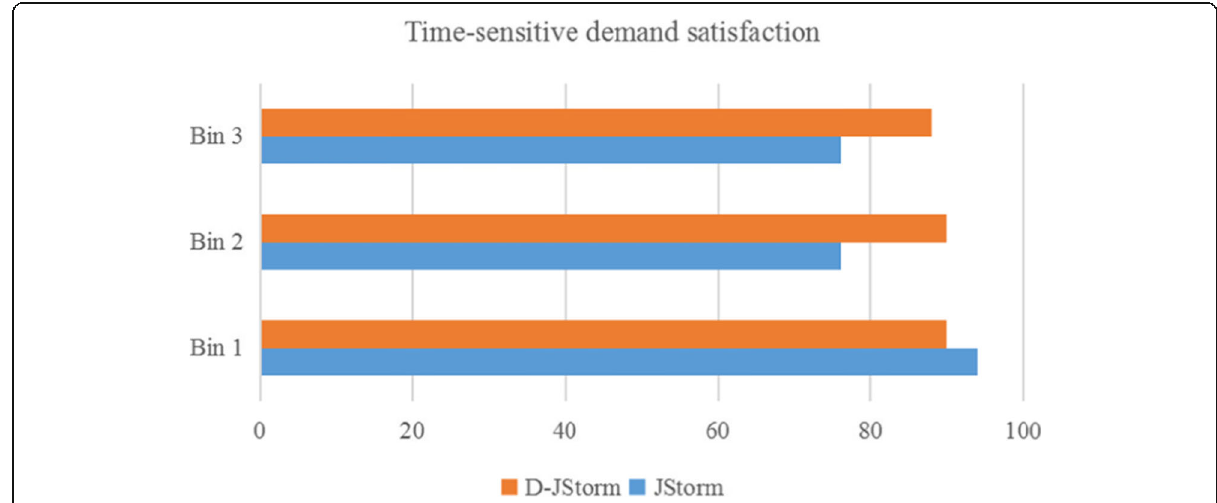
Fig. 3 Comparison of time-based demand satisfaction degree under different initial resource configurations